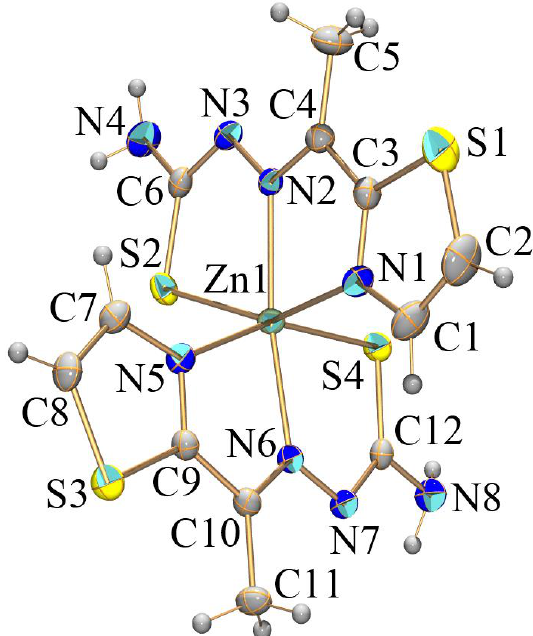
Figure 2. ORTEP presentation of the molecular structure of [Zn( L 2 ) 2 ] ( 2 ). Thermal ellipsoids are drawn at the 30% probability